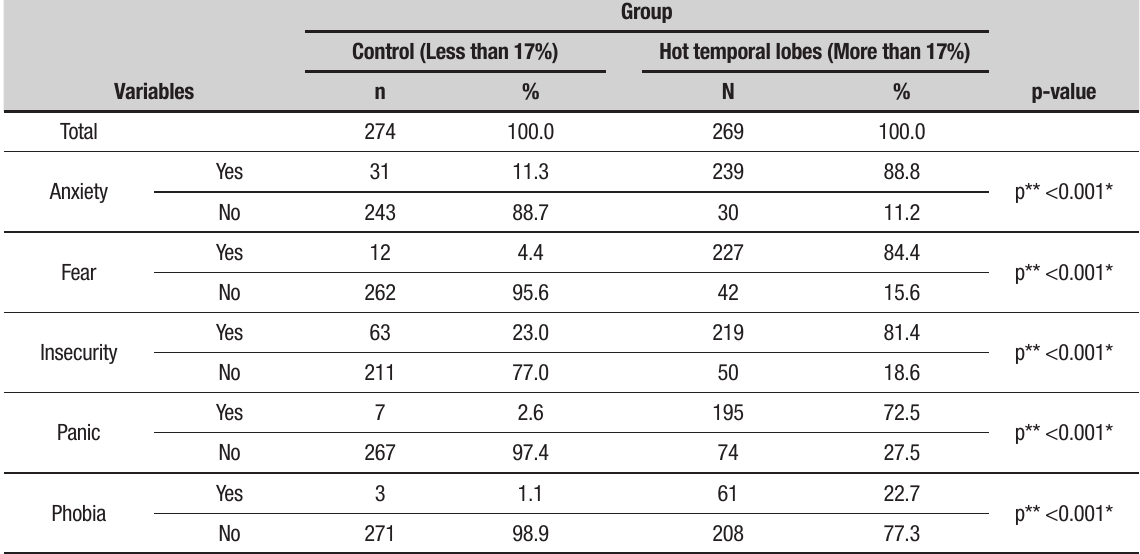
Table 3. Evaluation of symptoms according to group: Percent of Beta (15-23 Hz) wave in left temporal lobe (T4).